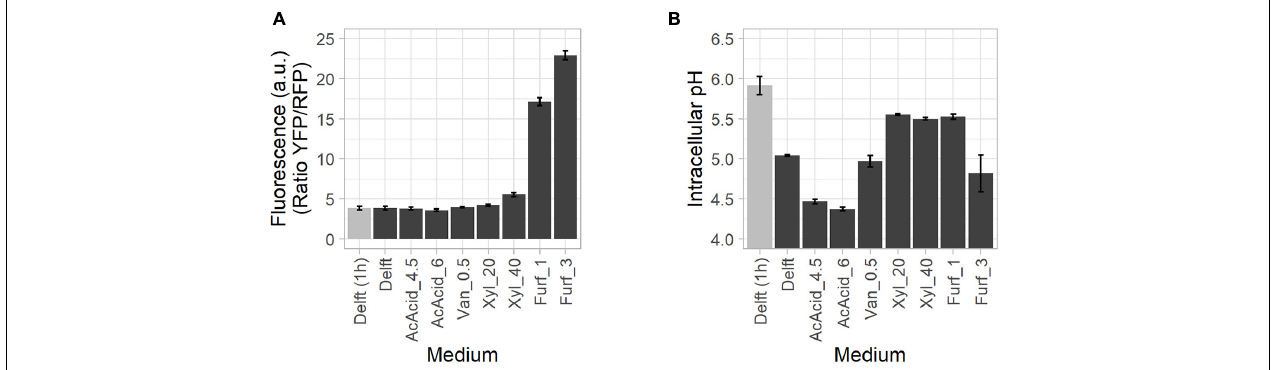
FIGURE 6 | Oxidative stress activation and drop in intracellular pH during growth in the presence of lignocellulosic inhibitors. CEN.PK113-7D cells were grown in the presence of lignocellulose-derived stressors, including acetic acid (AcAcid) at 4.5 and 6 g/L, vanillin (Van), xylose (Xyl) at 20 and 40 g/L, and furfural (Furf) at 1 and 3 g/L. (A) Oxidative stress response activation (highest values, in black) assessed with the OxPro biosensor. (B) Intracellular pH (lowest values, in black) assessed with the sfpHluorin biosensor. “Delft (1 h)” (in gray) refers to the parameter at 1 h after the onset of screening.